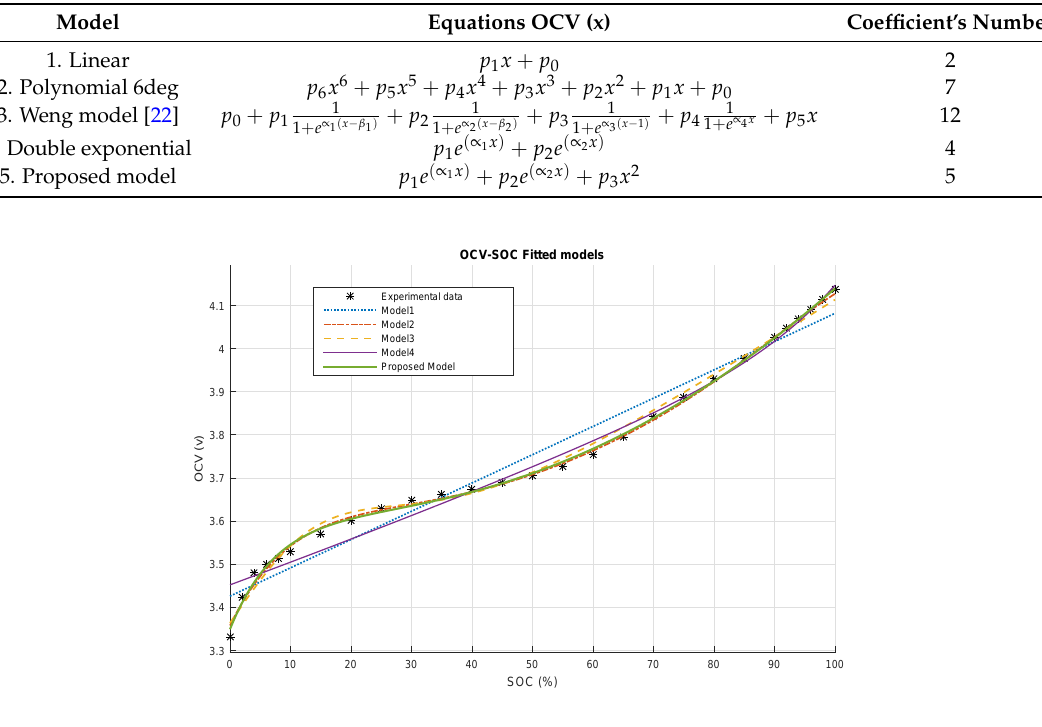
Figure 9. OCV fitting results at 25 ◦ for the